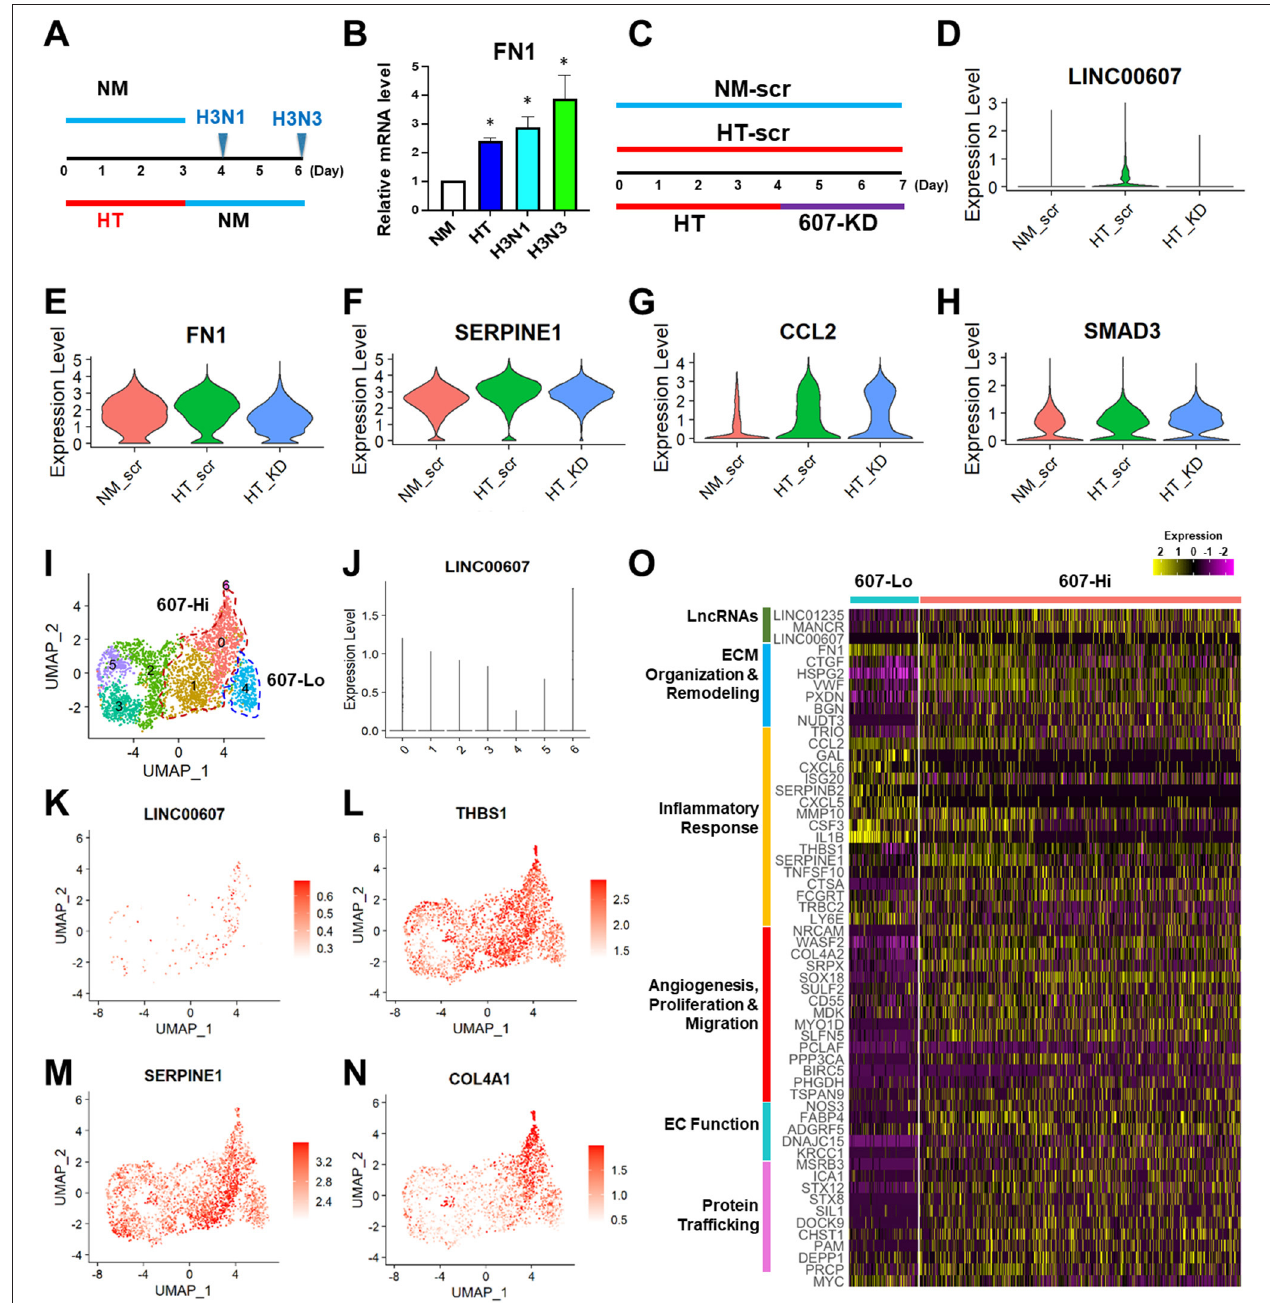
FIGURE 4 | LINC00607 inhibition reverses the effect of HT in ECs. (A) Experimental design of HT to NM switch experiment. HUVECs were treated with NM or HT for 3 days, and then switched to NM medium for another 1 (H3N1) or 3 days (H3N3) before cell harvest. (B) qPCR detection of FN1 mRNA levels from experiment shown as in (A) . (C) Experimental design of the “reverse” experiment. HUVECs in biological replicates were treated with NM or HT for 7 days, or HT for 4 days before LINC00607 knockdown using LNA GapmeR (607-KD). (D) LINC00607 expression quantified by scRNA-seq of three groups of ECs. (E–H) Representative reversible ( FN1 and SERPINE1 ) and irreversible ( CCL2 and SMAD3 ) DEGs. (I) UMAP of HT-KD scRNA-seq data. (J) LINC00607 expression in HT-KD samples shown on UMAP separated by 7 clusters. Note that Cluster 0, 1, and 6 show high LINC00607 levels (expression level > 1, i.e., 607-Hi cells) and Cluster 4 shows the lowest LINC00607 level (i.e., 607-Lo cells). (K) LINC00607 expression in 7 clusters of cells in HT-KD samples plotted by UMAP. (L–N) Representative DEGs in HT-KD samples plotted on UMAP. (O) Heatmap showing the expression of indicated DEGs in LINC00607-Lo vs. -Hi ECs.